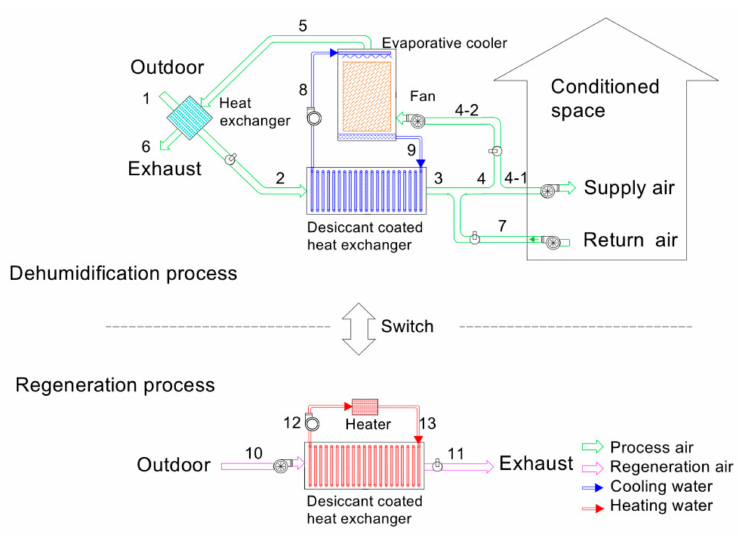
Figure 2. Schematic of self-cooled desiccant-coated heat exchanger cooling system